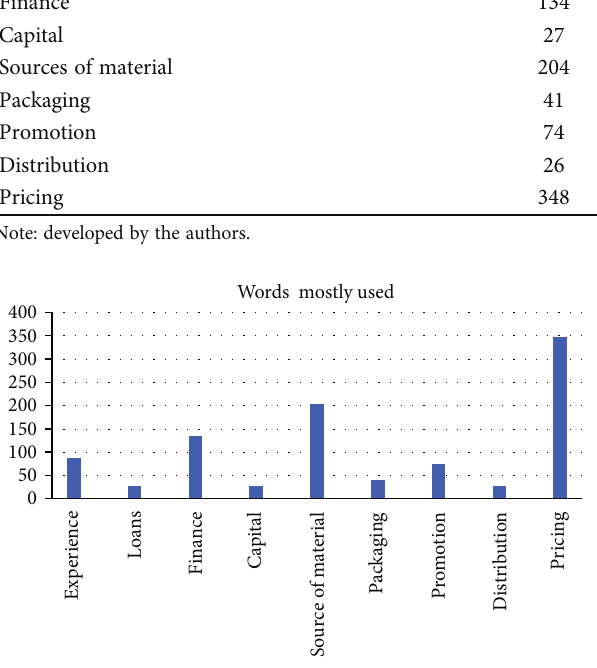
Figure 2: Bar chart for words mostly used (note: developed by the